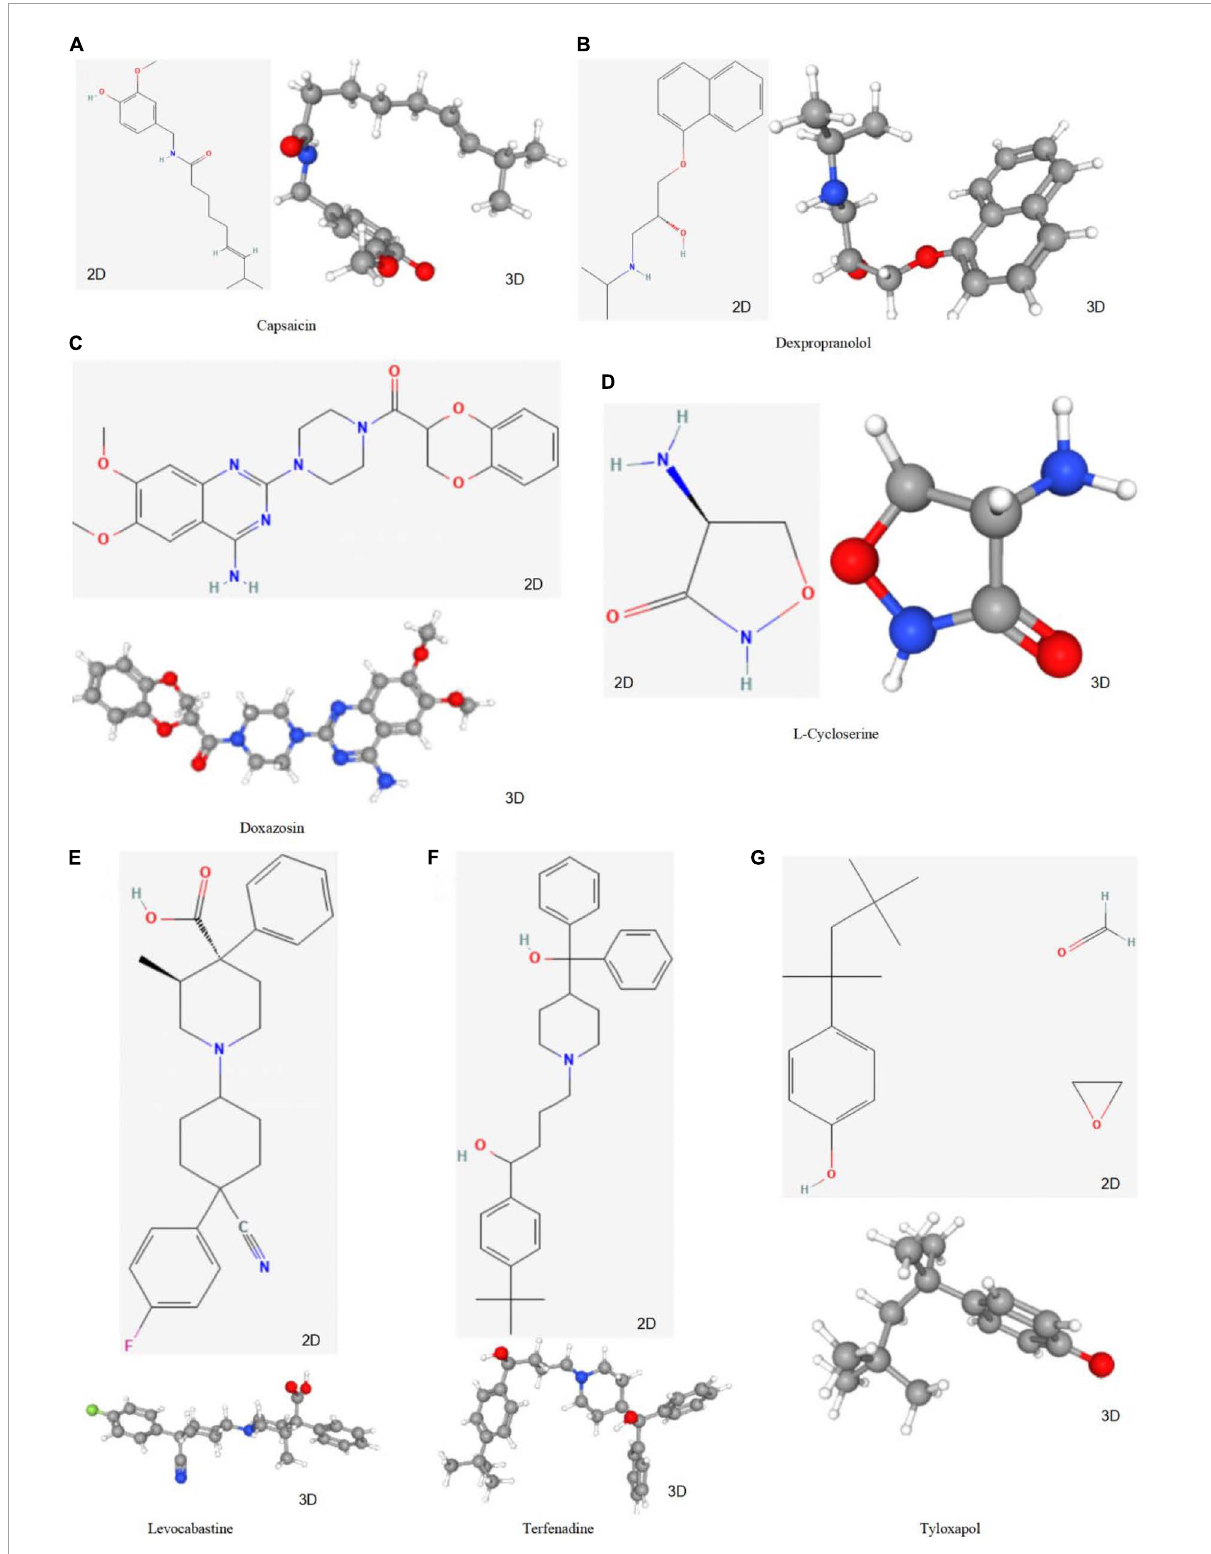
FIGURE12 The structure of small molecule drugs screened based on CMap. (A) Capsaicin’s 2D and 3D structure. (B) Dexpropranolol’s 2D and 3D structure. (C) Doxazosin’s 2D and 3D structure. (D) L -Cycloserine’s 2D and 3D structure. (E) Levocabastine’s 2D and 3D structure. (F) Terfenadine’s 2D and 3D structure. (G) Tyloxapol’s 2D and 3D